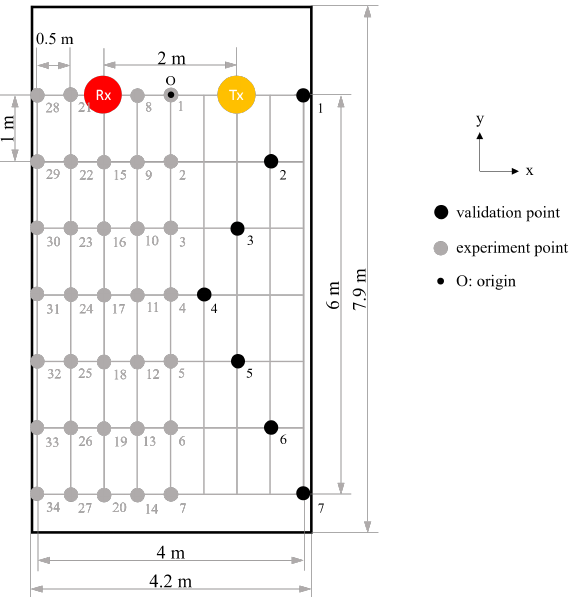
Figure 5. Experimental deployment for detecting the resting tremor using a single WiFi link.